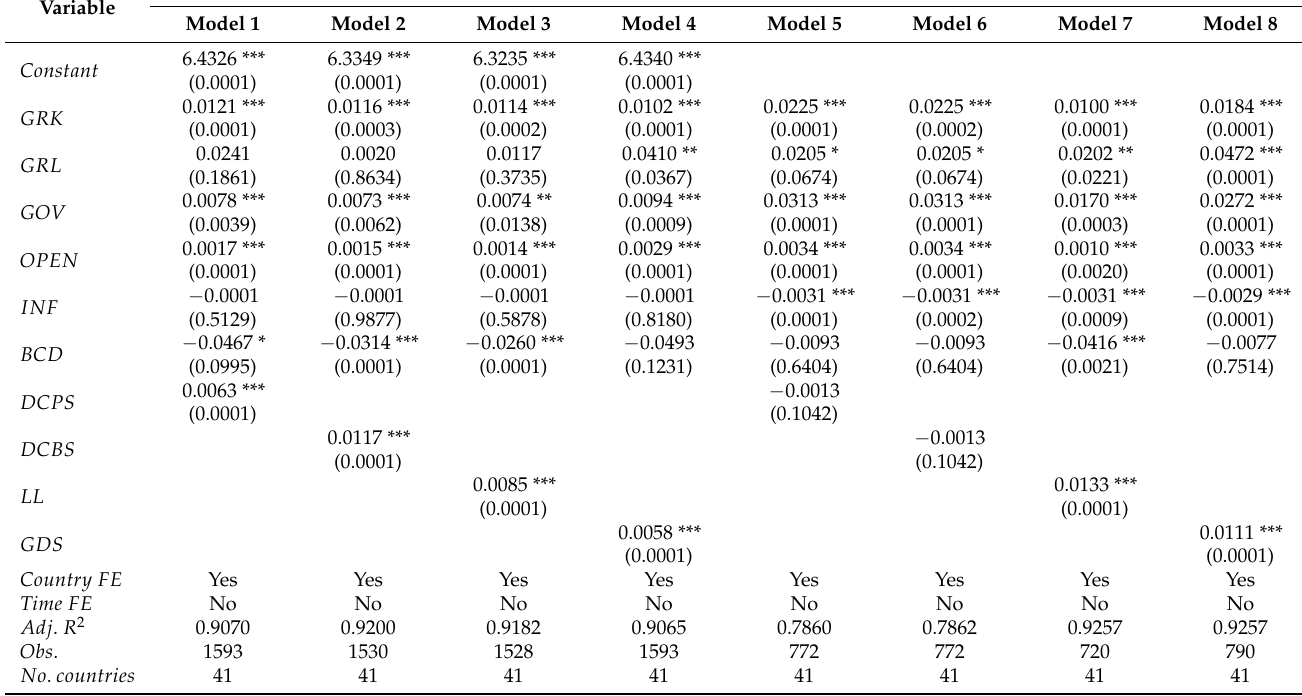
Note : This table shows the regression results for economic growth determinants for six geographic regional groups. The heteroskedastic- robust adjusted standard errors are in parentheses. The signs ***, **, and * indicate statistical significance of F-statistic at 1%, 5%, and 10% levels, respectively. Each equation is estimated using Panel Least Squares and Panel Fully Modified Least Squares estimation